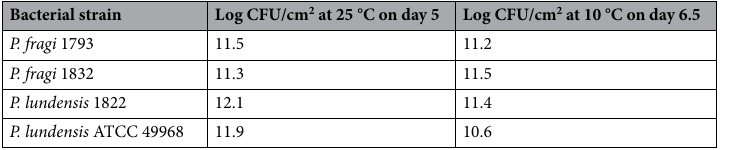
Table 1. Cell counts in mono-species biofilms of the P. fragi and P. lundensis strains grown at 25 °C and 10 °C on nitro-cellulose membranes placed on meat.